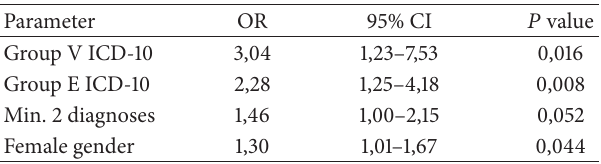
Table 3: The values of the OR of SCA in patients at significant risk for this complication, as defined in the multivariate logistic regression